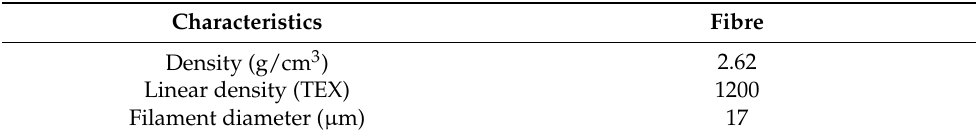
Table 4. Fibre characteristic from 3B